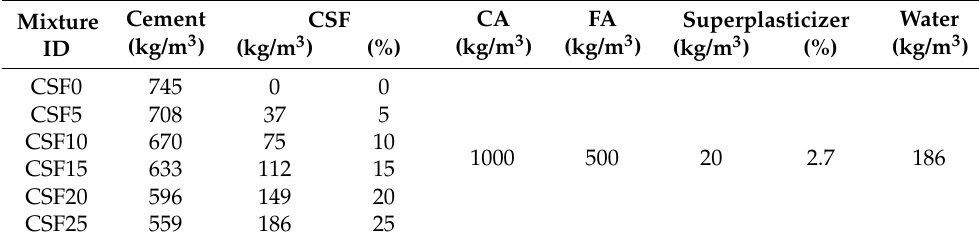
Table 3. Mixture proportions of HPCs.